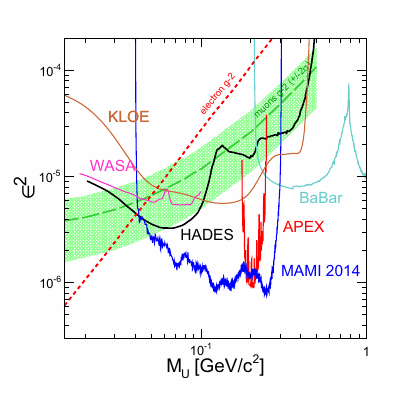
Figure 1. (Color online) The 90% Cl upper limit on (cid:3) 2 versus the U-boson mass obtained from the combined analysis of the HADES data (solid black curve) in comparison with existing limits from the MAMI / A1, APEX, BaBar, WASA, and KLOE-2 experiments. In addition the g − 2 constrains are also